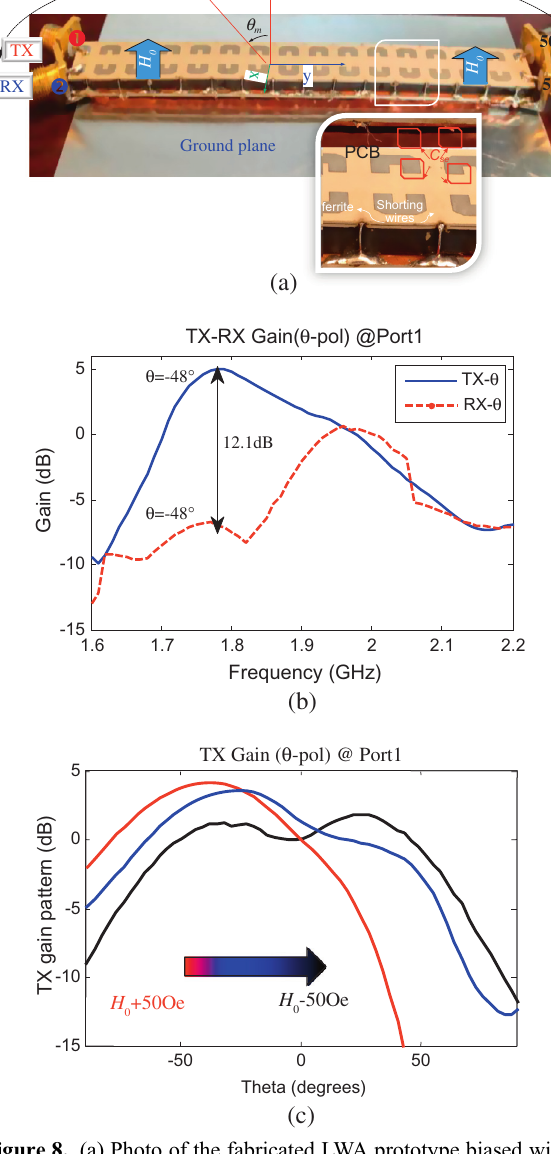
Figure 8. (a) Photo of the fabricated LWA prototype biased with an external magnetic field of H 0 = 1900 ± 150 Oe. (b) Measured TX and RX gain patterns at port 1 and as a function of frequency, with port 3&4 terminated at 50 X . (c) Scanned TX antenna pattern at port 1 by changing the external bias field H 0 by ±50